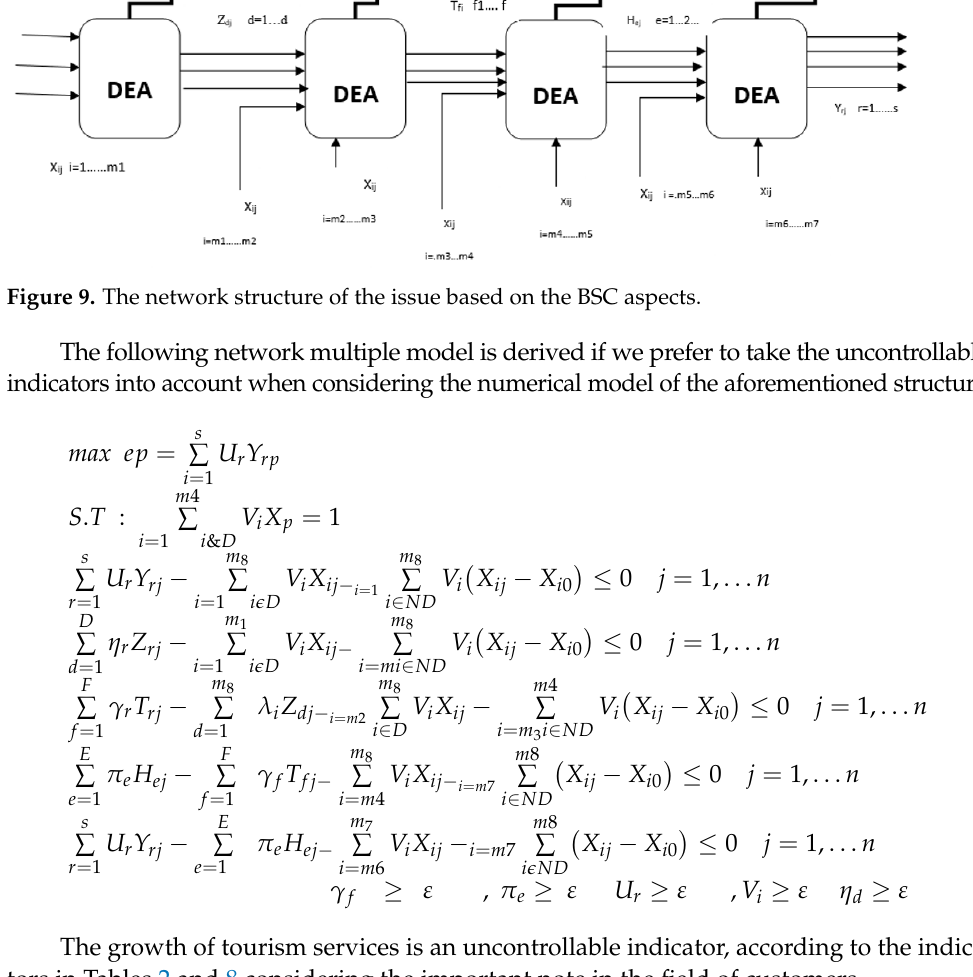
Table 8. Serial evaluation